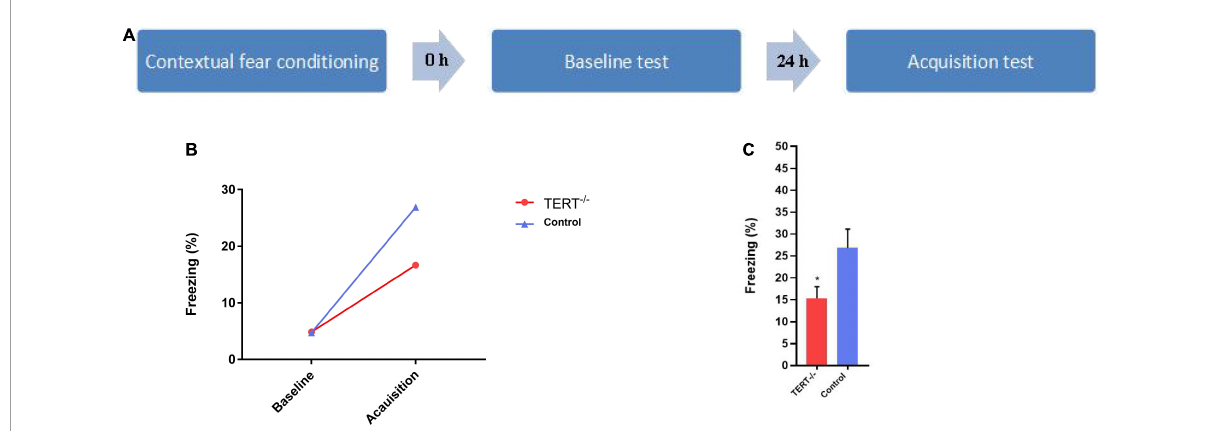
FIGURE1 The impairment of recent fear memory in TERT − / − mice in contextual fear conditioning. (A) Schematic representation of the behavioral protocol. (B) There was no difference in the probability of freezing behavior in the two groups at baseline during the test, but both groups have a significant increase of freezing time percentage after 24 h. (C) The acquisition of fear memory has a significant difference between TERT − / − mice and normal TERT gene mice (* P < 0.05), the acquisition of recent fear memory in TERT − / − mice is lower than this in control